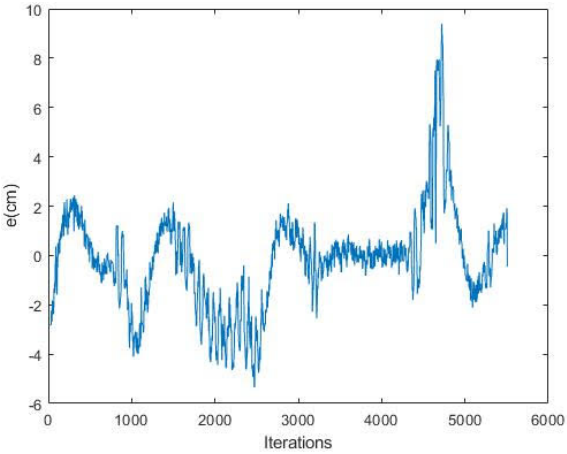
Figure 11. Positioning error values in a specific trajectory.